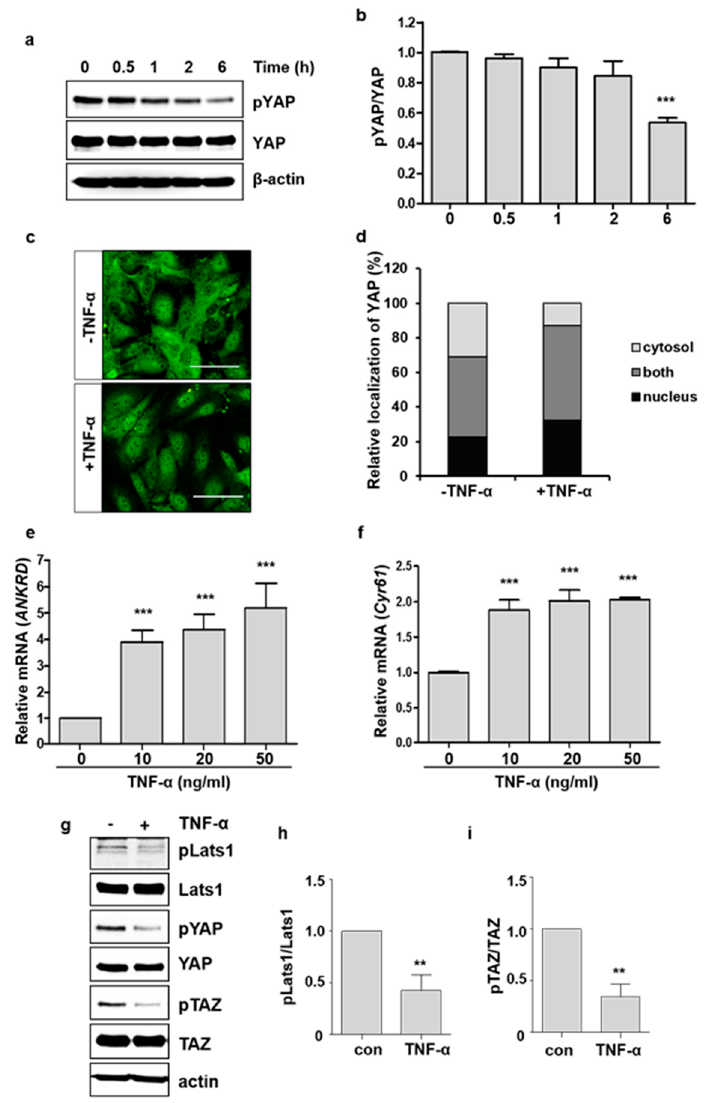
Figure 1. TNF- α induces YAP nuclear translocation and activation in endothelial cells. ( a ) HUVECs were treated with 20 ng/mL of TNF- α at different times. pYAP (S127) and YAP levels were analyzed by immunoblotting. The phosphorylation of the YAP S127 residue was decreased by TNF- α in a time-dependent manner. ( b ) YAP phosphorylation was quantified. ( c ) HUVECs were cultured in the absence or presence of TNF- α for 6 h. Endogenous YAP was stained using anti-YAP antibody. Green: YAP. Scale bar: 200 µ m. ( d ) YAP localization was quantified. The labels nucleus, both, and cytosol indicate nuclear, both nuclear and cytoplasmic, and cytoplasmic YAP localization, respectively. ( e , f ) HUVECs were treated with TNF- α for 6 h, and the mRNA levels of ANKRD and C61 were measured by qRT-PCR. ( g – i ) HUVECs were treated with TNF- α for 6 h. Cell lysates were immunoblotted with anti-pLats1 (T1079), Lats1, pYAP, YAP, pTAZ (S89), and TAZ antibodies. ( g ) Representative immunoblot is shown. Phosphorylation of Lats1 (h) and TAZ ( i ) was quantified. Data are presented as the mean ± S.E. ( n = 3 independent experiments). *** p < 0.001 and ** p < 0.01 vs. control.